Question: Summarize what this figure shows in one sentence.
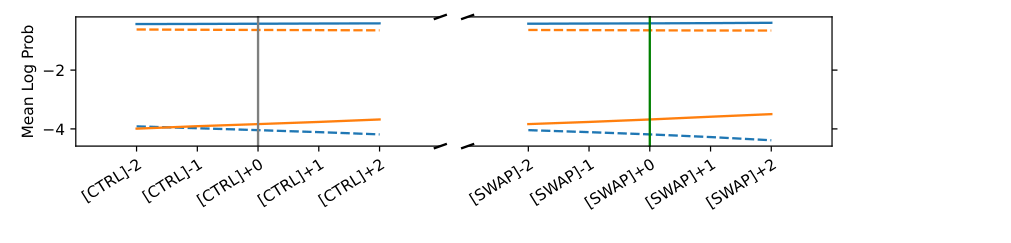
Answer: Position independence for ONEHOP. Top: Mean log probs for entity interventions. Bot- tom: Mean log probs for attributes. Different from Fig. 4, we only compute the local neighborhood around the control and swapped conditions.